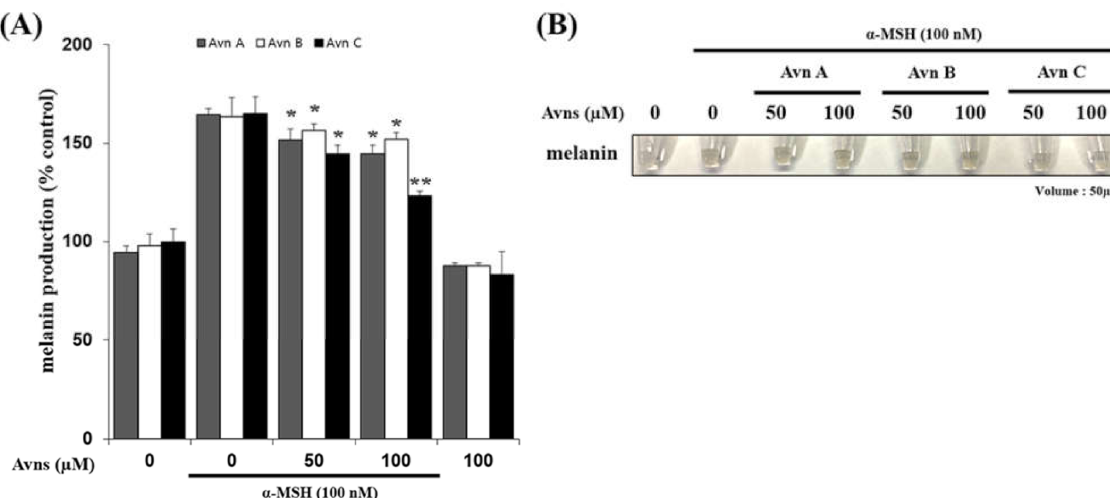
Figure 3. Inhibitory effect of Avenanthramides (A, B, C) on melanin production in α -MSH-activated SK-MEL-2 cells. ( A ) melanin production was inhibited by treatment with AvnA, AvnB, and AvnC at every concentration tested (0, 50, 100 µ M). ( B ) melanin production photograph with AvnA, AvnB, and AvnC at concentration tested (0, 50, 100 µ M). The results shown are mean ± SEM and represent three independent tests. * p < 0.05 and ** p < 0.01 = significant differences from the α -MSH treated